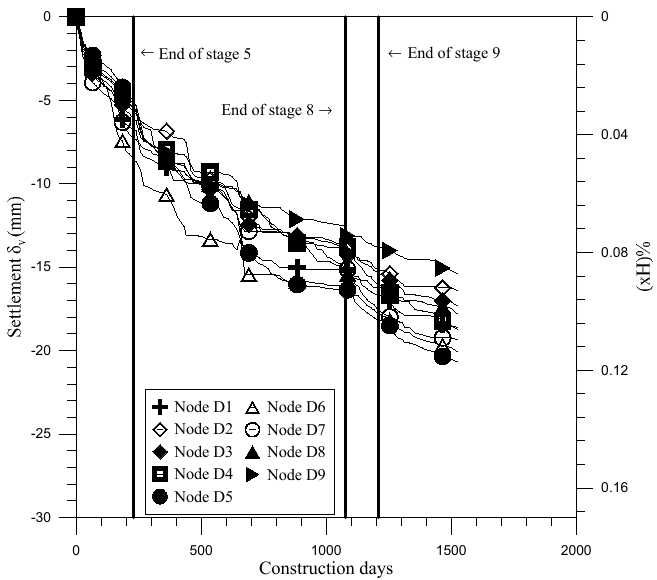
Figure 12. Building settlement of points 1–9.